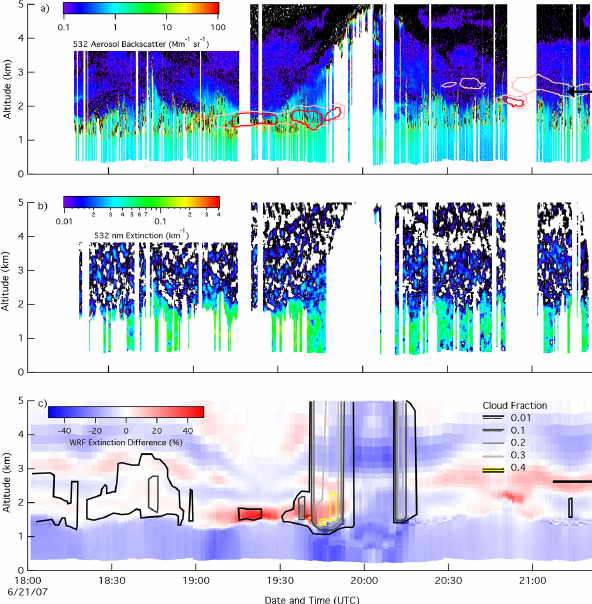
Figure 8. Same as Fig. 7 but for 21 June